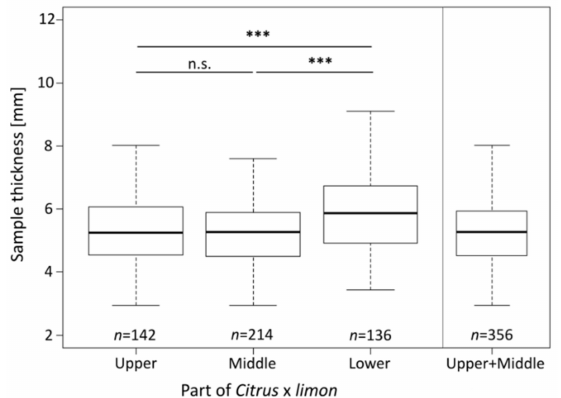
Figure 4. Sample thickness according to the parts within the fruit. The sample thickness of each sample was measured three times with a digital caliper. The level of statistical significance is indicated in the figure as follows: n.s.: p ≥ 0.05; ***: p <